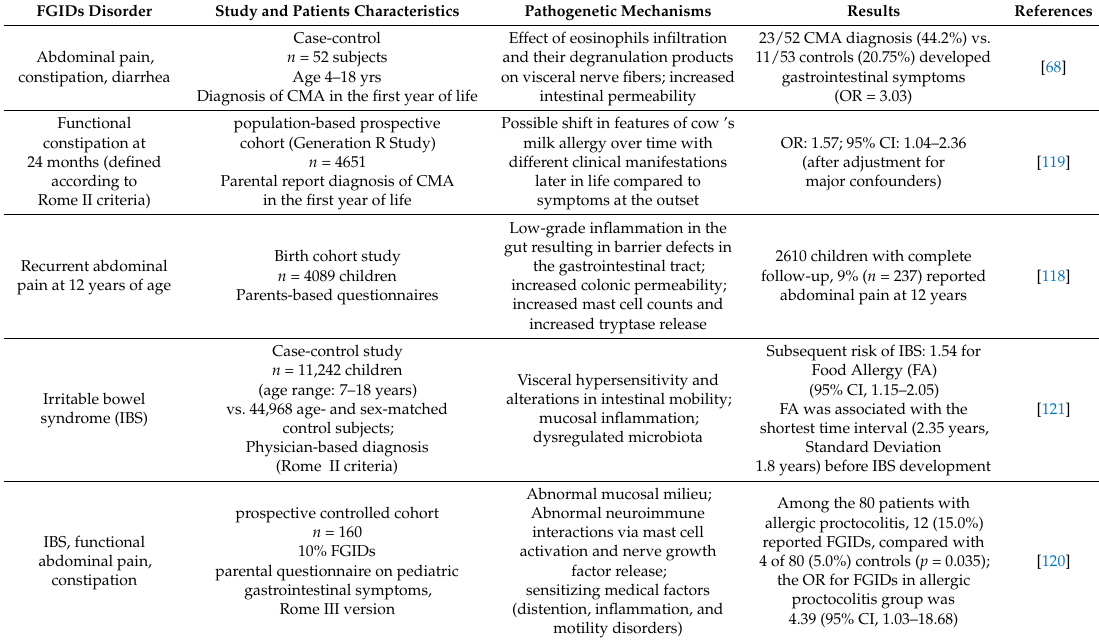
Table 1. Characteristics of pediatric studies evaluating cow’s milk allergy (CMA) as risk factor for functional gastrointestinal disorders